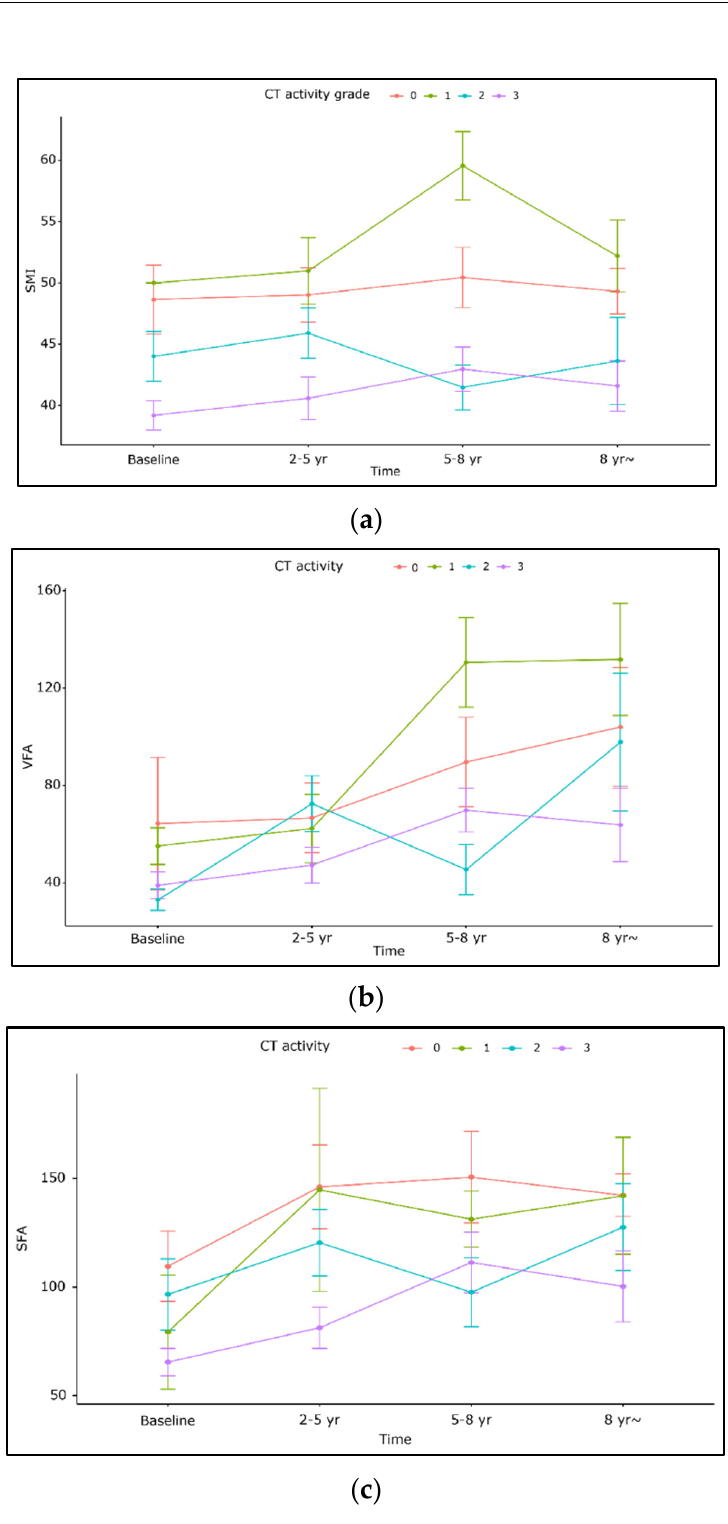
Figure 2. Changes in body composition stratified by CT activity grades. ( a ) SMI, ( b ) VFA, ( c ) SFA.